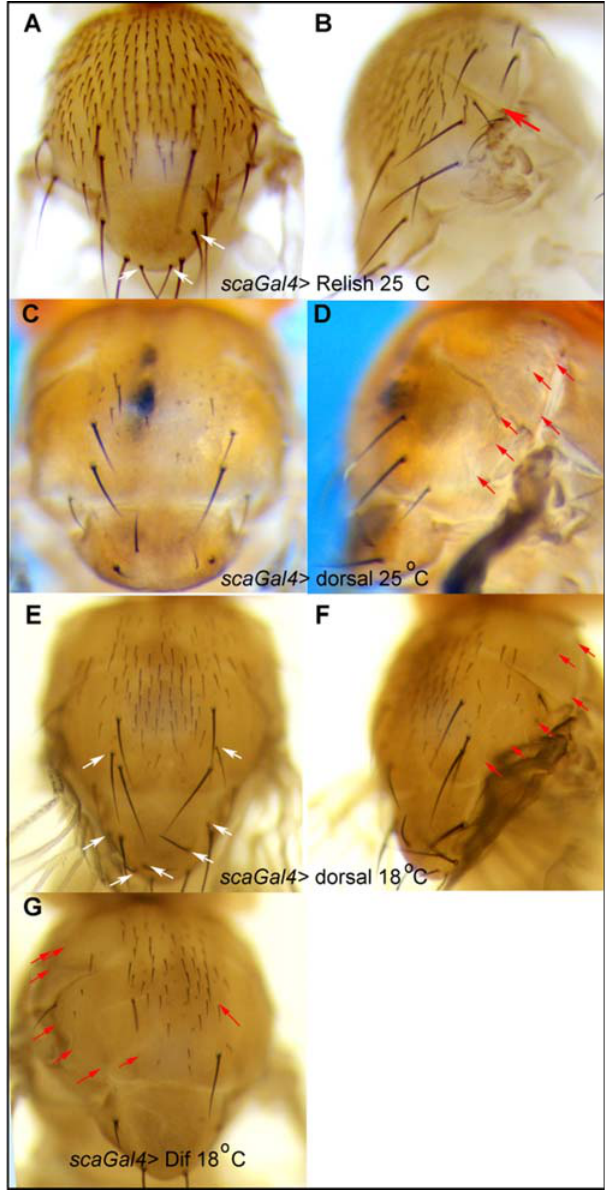
Figure 2. Over-expression of NF- k B/Rel proteins can result in both loss and gain of macrochaetes. scabrous[537.4]Gal4 was used to over- express Relish (A, B) Dorsal (C–F) and Dif (G) in proneural clusters. This resulted in a loss of bristles in lateral regions (red arrows in B, D, F and G). Ectopic bristles were present in medial regions of animals after over- expression of Relish and Dorsal (white arrows in A, E).